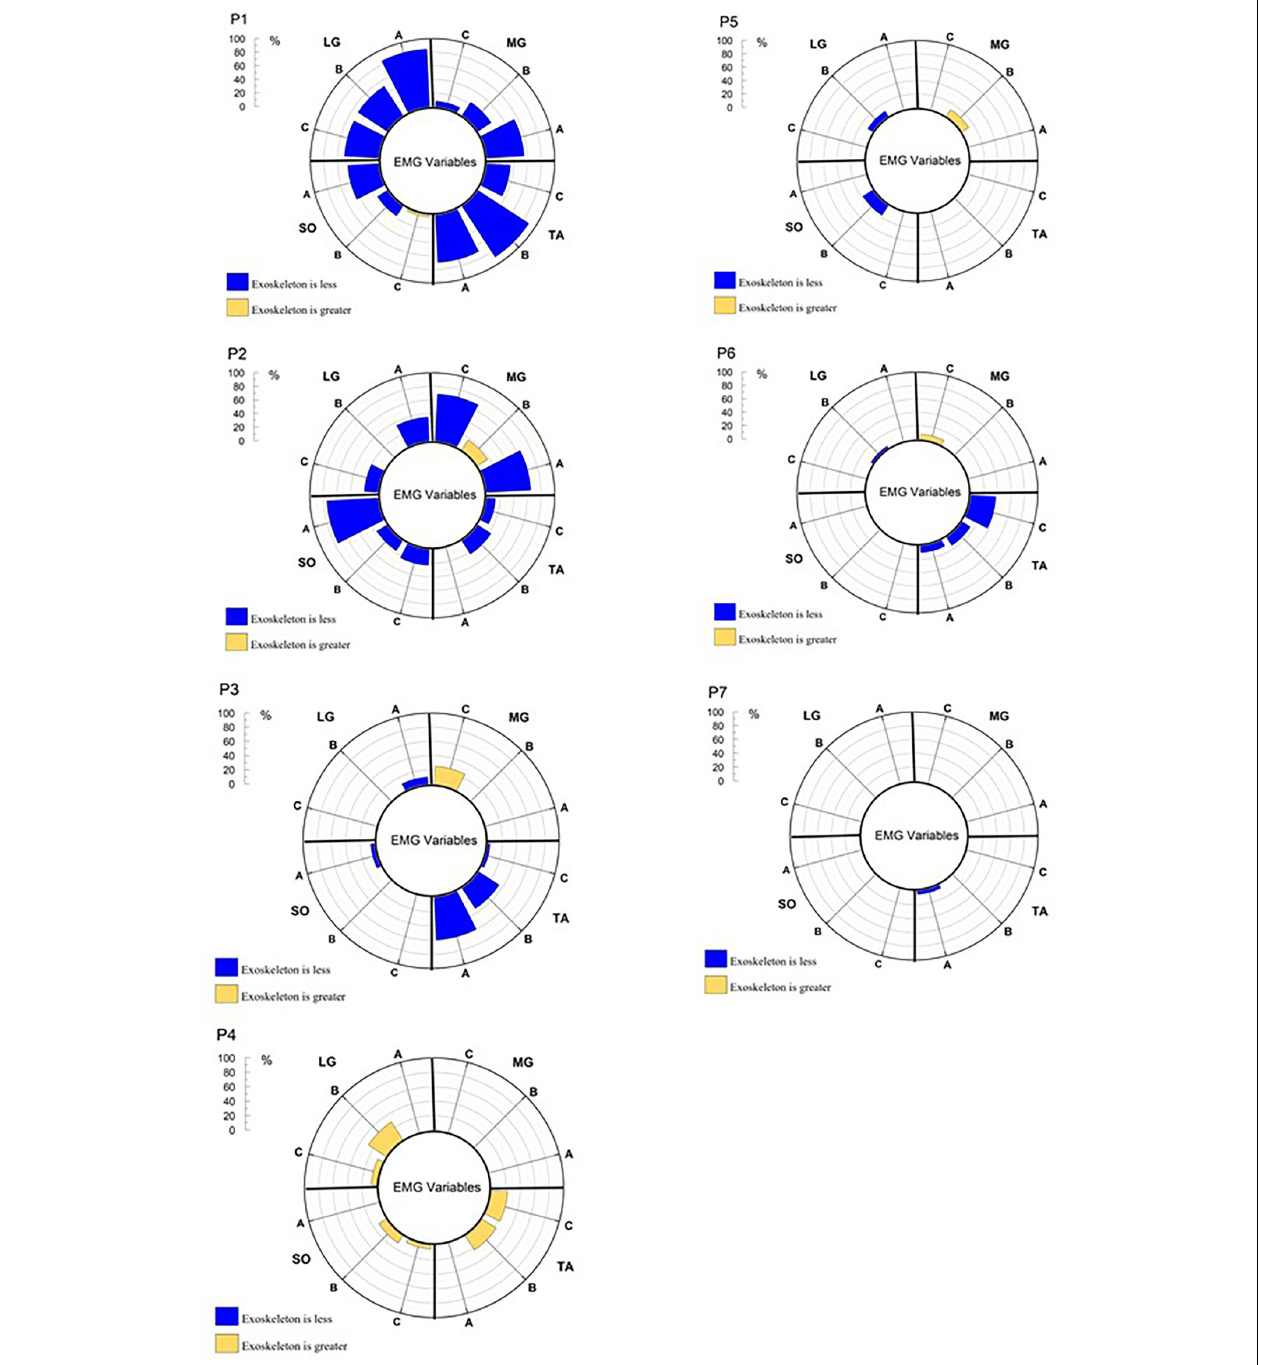
FIGURE 5 | The percentage of significant SPM testing t-values for each analysis epoch for the EMG activation waveforms, by muscle and participant.